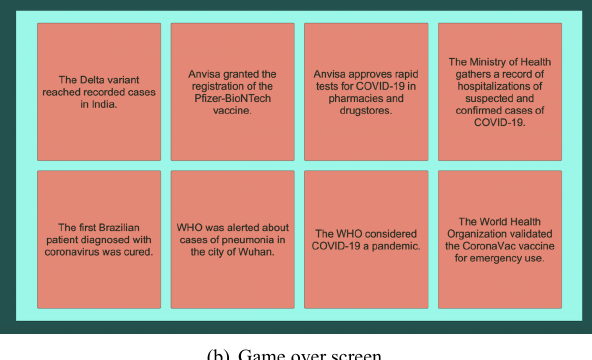
Figure 9. Example of screens from Minigame 1